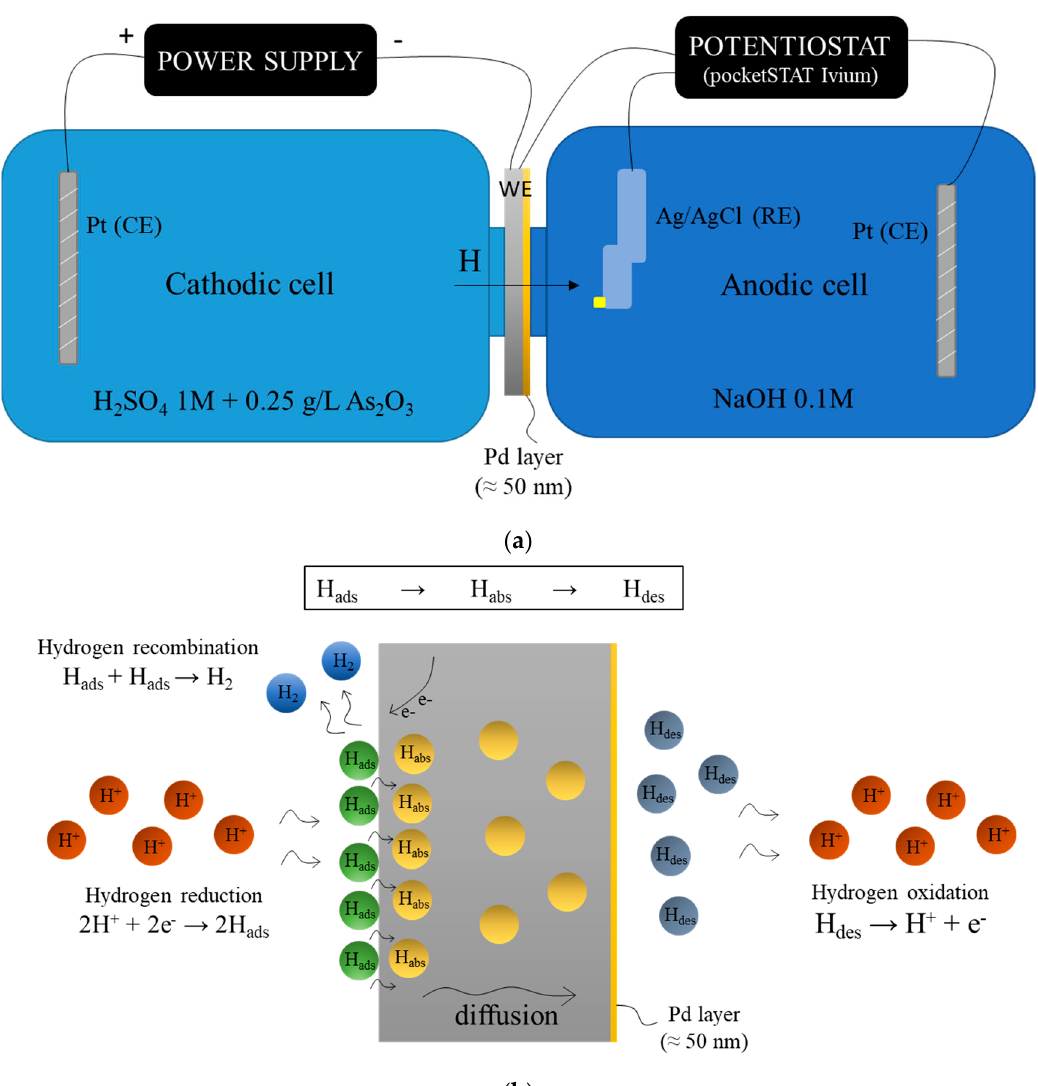
Figure 1. ( a ) Scheme of the permeation double-cell employed in this work and ( b ) all the steps taking place in the hydrogen permeation process, from hydrogen reduction in the cathodic cell (left) to hydrogen oxidation in the anodic cell (right).